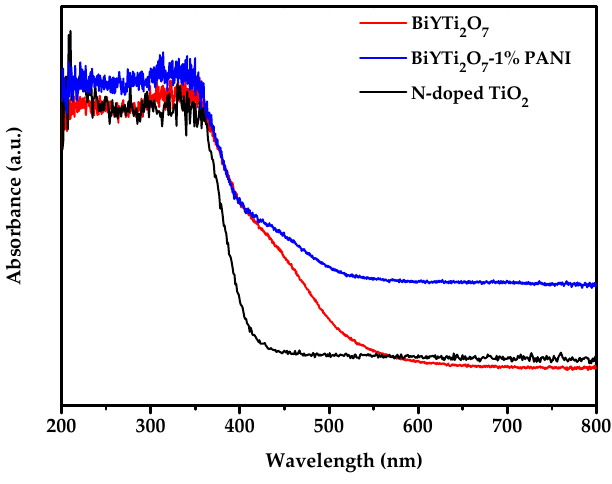
Figure 8. Absorption spectra of BiYTi 2 O 7 , BiYTi 2 O 7 -1% PANI and N-doped TiO 2 .